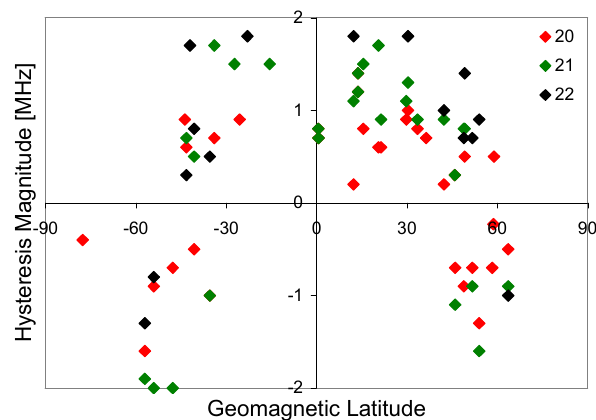
Fig. 2. fo F2 hysteresis magnitude (maximum difference during a Figure 2. foF2 hysteresis magnitude (maximum difference during a given solar cycle given solar cycle between fo F2 value in the falling phase and the between foF2 value in the falling phase and the corresponding value in the rising phase corresponding value in the rising phase for a constant R z ) for so- for a constant Rz) for solar cycles 20 (red diamonds), 21 (green diamonds) and 22 lar cycles 20 (red diamonds), 21 (green diamonds) and 22 (black (black diamonds).